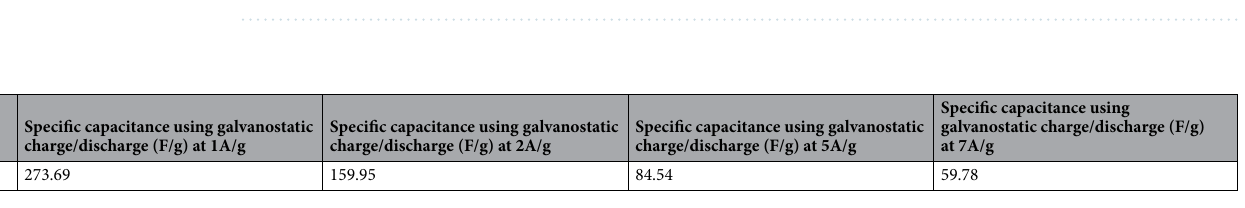
Table 2. Specific capacitance obtained from the cyclic voltammetry analysis at different scan rates.